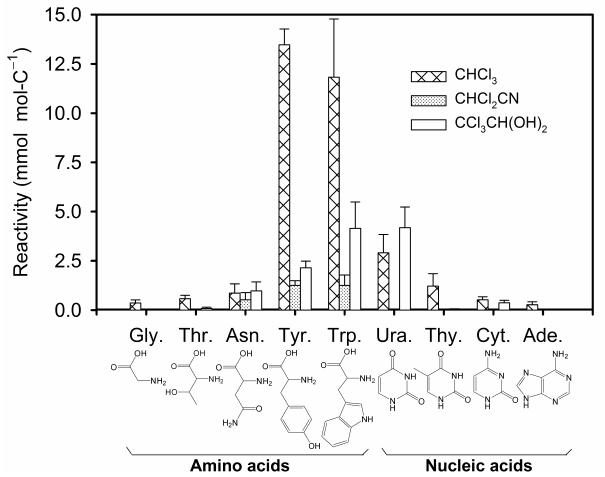
Fig. 2. Halogenation reactivity of 9 bacterial cellular monomers. Error bars show standard deviation from a total of 10 replicates (two for each C concentration: 0.083, 0.167, 0.250, 0.333, and 0.5mmol- Cl − 1 ) .